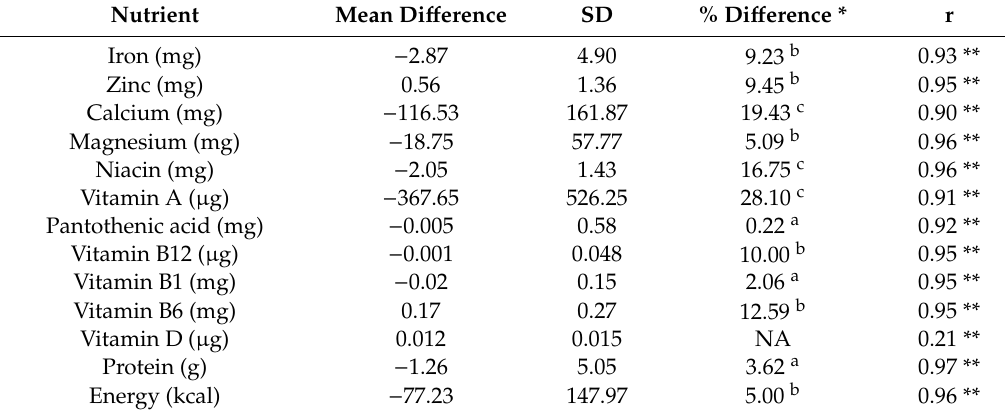
Table 3. Average mean and standard deviation (SD) of the di ff erence between the nutrient intake computed by CIMI-Ethiopia minus the intake calculated by NS in two seasons, and the Pearson’s coe ffi cients (r) between intakes computed by CIMI-Ethiopia and NS (N = 1154). Nutrient Mean Di ff erence SD % Di ff erence * r Iron (mg) − 2.87